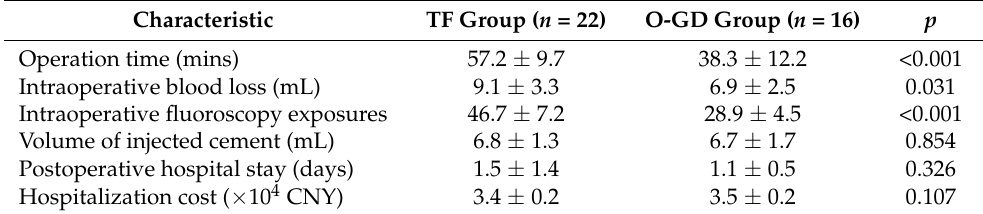
Table 2. Comparison of changes in perioperative parameters between the 2 groups.